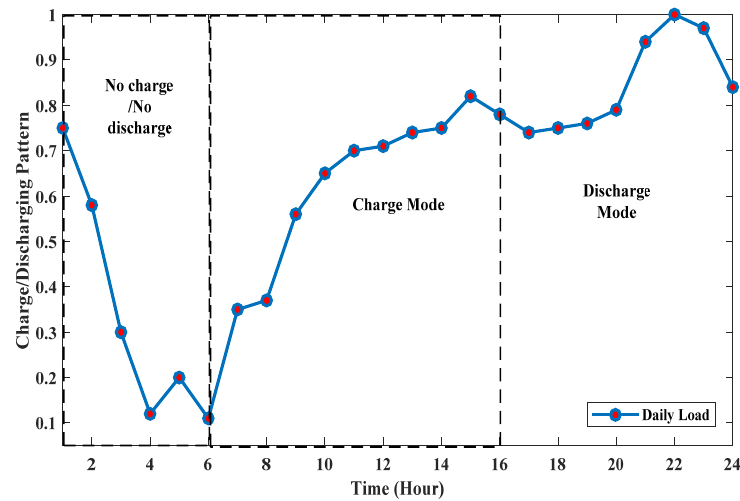
Figure 7. Charge/discharge pattern.